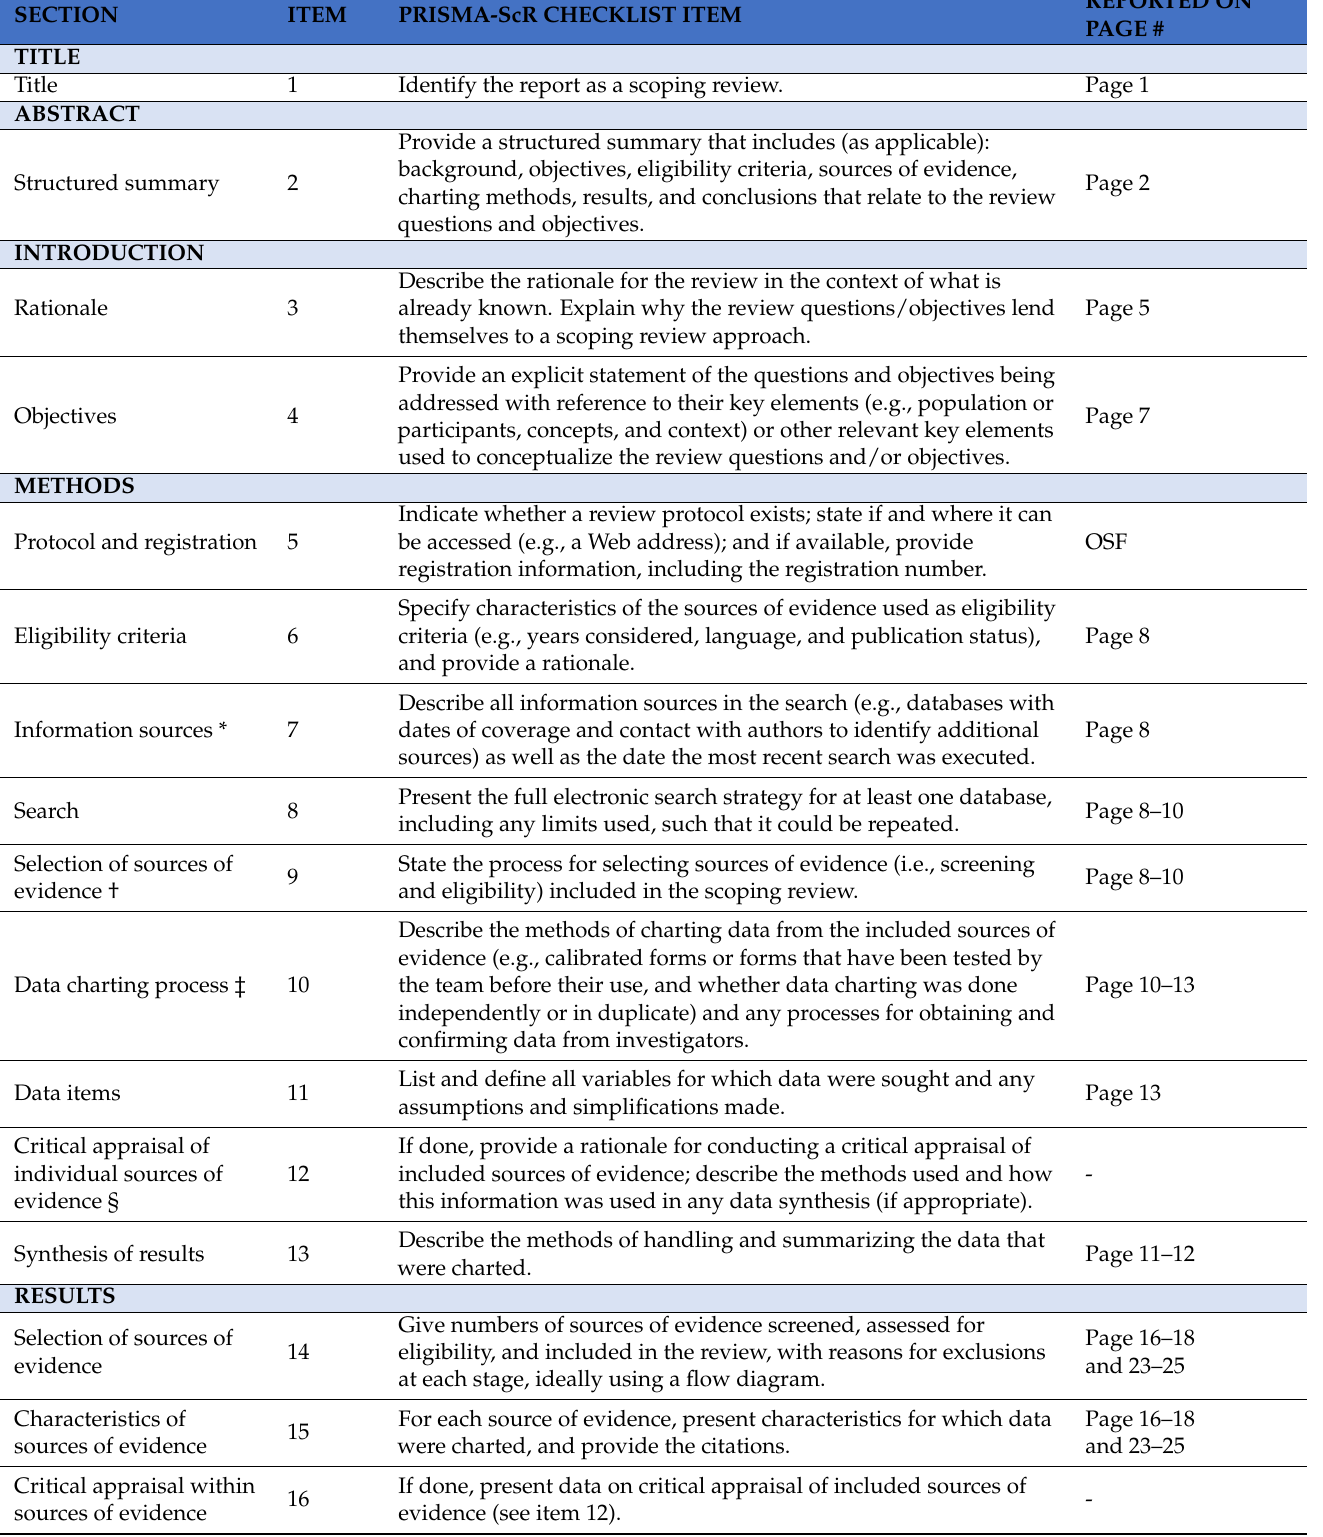
Table A2. Preferred Reporting Items for Systematic reviews and Meta-Analyses extension for Scoping Reviews (PRISMA-ScR)